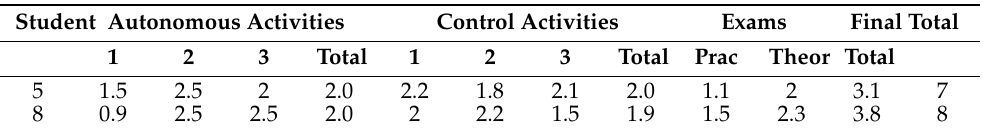
Table 4. Qualifications of the students who presented major problems in the development of practical activities, after the system will recommend activities aligned to their